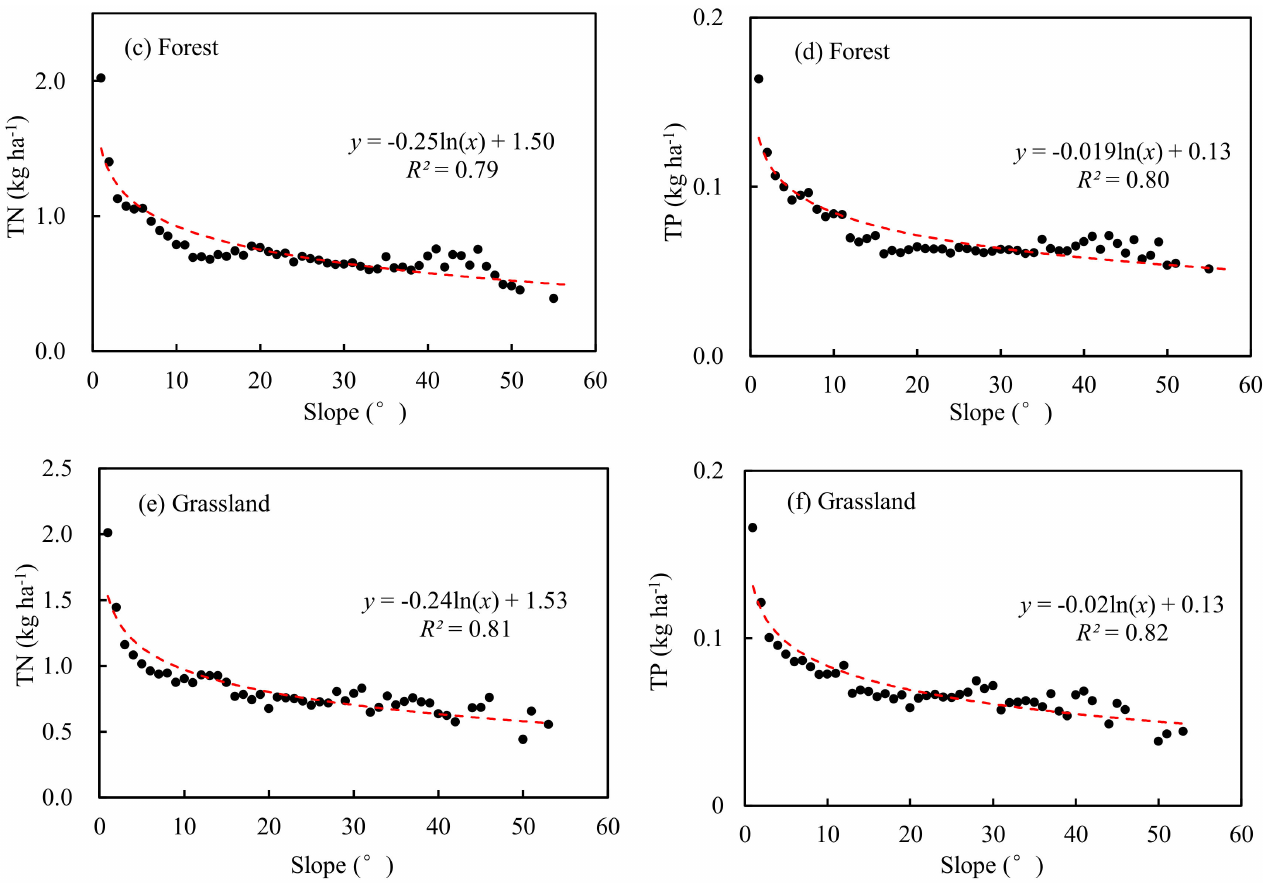
Figure 12. The distribution characteristics of the pollution load intensities of the same land use types with different slopes: TN for farmland ( a ), forest ( c ) and grassland ( e ), TP for farmland ( b ), forest ( d ) and grassland ( f